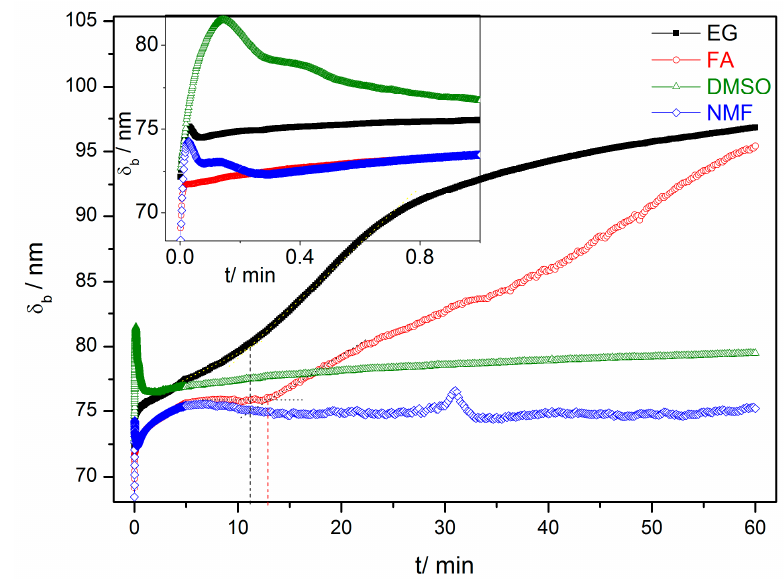
Figure 3. HfO 2 barrier layer thickness ( δ b ) during the first hour of anodization for the EG, FA, NMF and DMSO